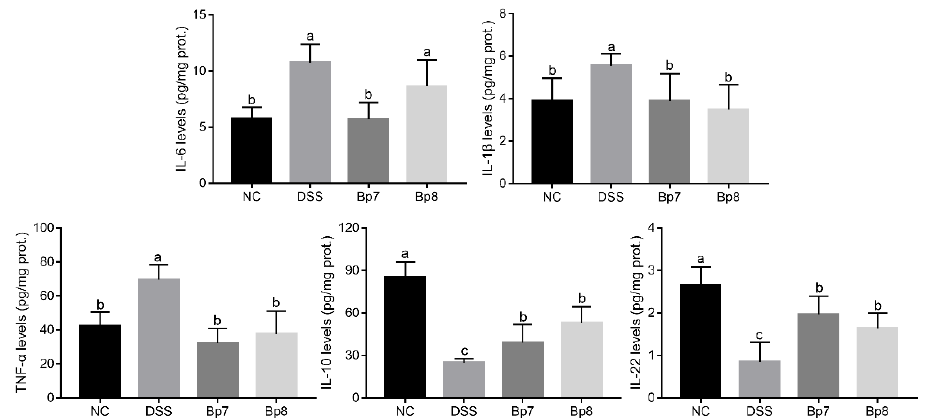
Figure 2. Influences of Bp7 and Bp8 intervention on the colonic inflammatory cytokines ( n = 8). The different letters represent significant differences between experimental groups ( p < 0.05).